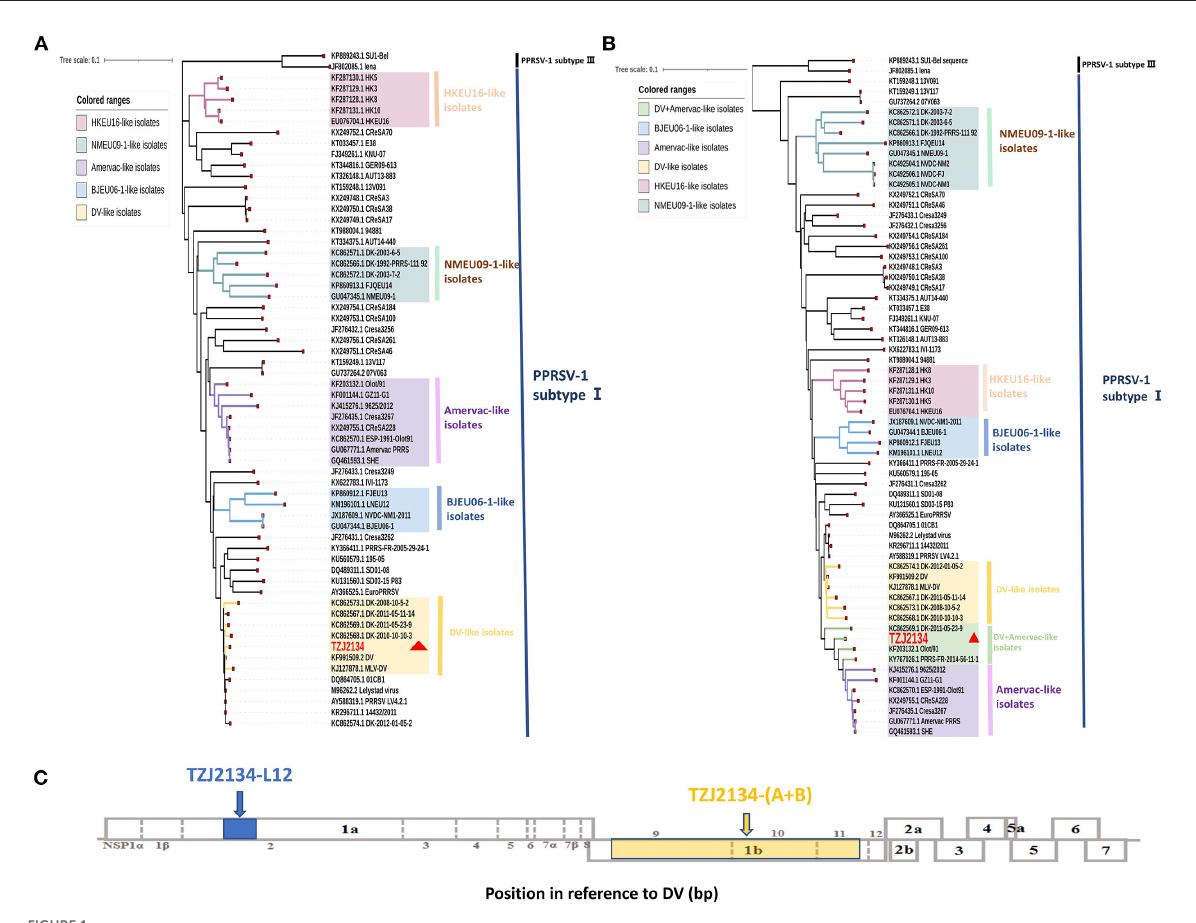
FIGURE1 Phylogenetic analysis based on the TZJ2134-L12 and TZJ2134-(A + B) gene sequences and positions of TZJ2134-L12 and TZJ2134-(A + B) in the whole genome structure. (A) Phylogenetic tree based on TZJ2134-L12 of 60 PRRSV-1 strains. The TZJ2134 and DV strains belong to DV-like isolates, which are shown in yellow. (B) Phylogenetic tree based on TZJ2134-(A + B) of 65 PRRSV-1 strains. A novel subgroup DV + Amervac-like isolate is shown in green. (C) The whole genome structure of PRRSV, which shows the positions of 10 open reading frames. TZJ2134-L12 is located at nt 1672-nt 2112 in partial Nsp2, shown in blue; TZJ2134-(A + B) is located at nt 7463-nt 11272 in partial Nsp9, complete Nsp10 and partial Nsp11, shown in yellow. TZJ2134 is indicated with a red triangle in phylogenetic trees.